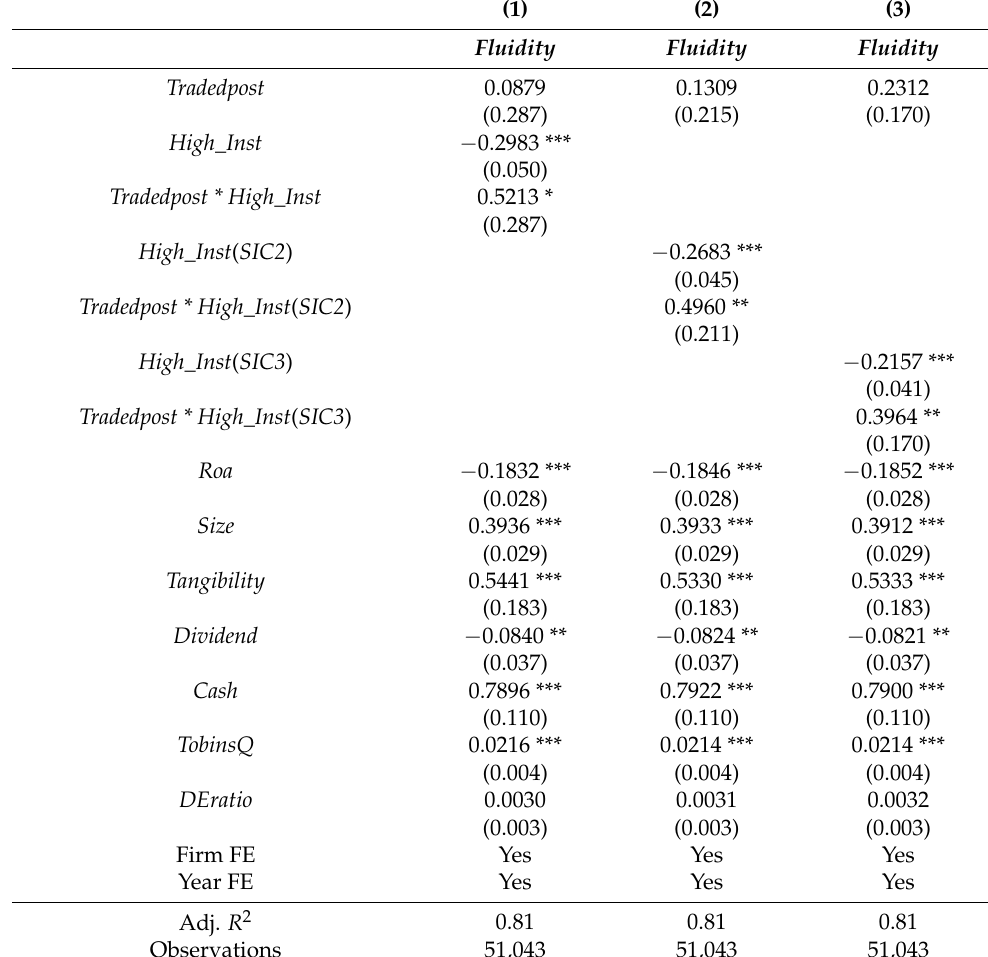
Table 5. CDS initiation and institutional holdings. This table reports the results of regression model (2) using our main competition measure, Fluidity . Standard errors were clustered by firms and reported in parentheses. Lagged firm-specific controls and firm and year fixed effects are included in all specifications. Coefficients with *, **, or *** indicate a significance level of 0.10, 0.05, or 0.01, respectively. For detailed definitions of variables, please refer to Appendix A Table